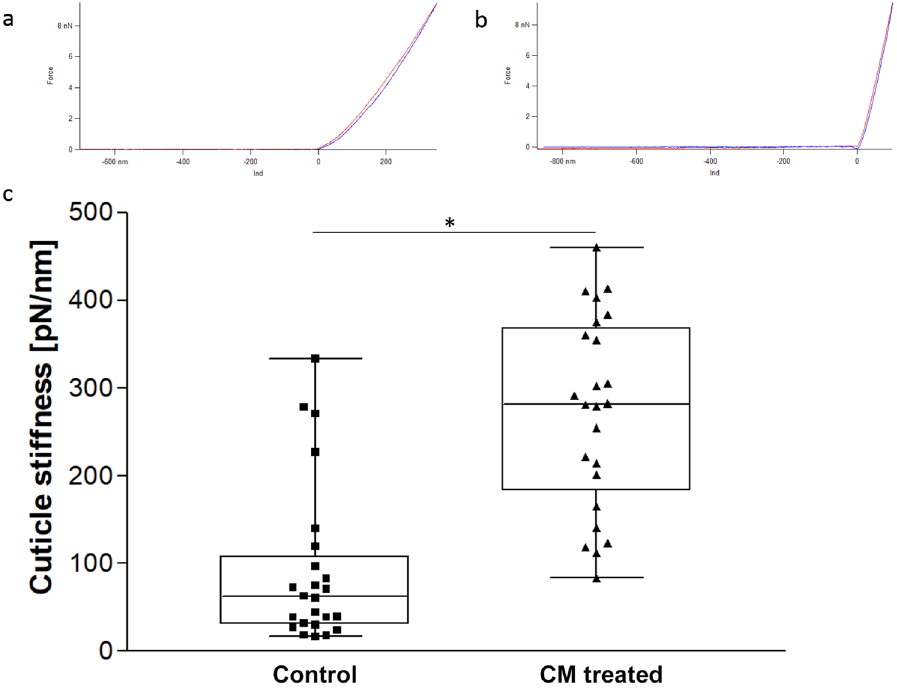
Figure 6. Mean stiffness of single worms measured via AFM force spectroscopy. Every point represents the mean stiffness of a single worm measured at 3 to 10 different positions. Upper panel: Exemplary force-distance curves for a measuring point on an untreated ( a ) and a treated ( b ) worm. The indentation depth is plotted against the applied force. ( c ) Boxplot showing the maximum, the 75% percentile, the median, the 25% percentile and the minimum. The significant upwards shift of the boxplot of treated worms compared to untreated individuals ( p < 0.001) indicates an increase in cuticle stiffness after CM treatment (2 mg/mL, 24